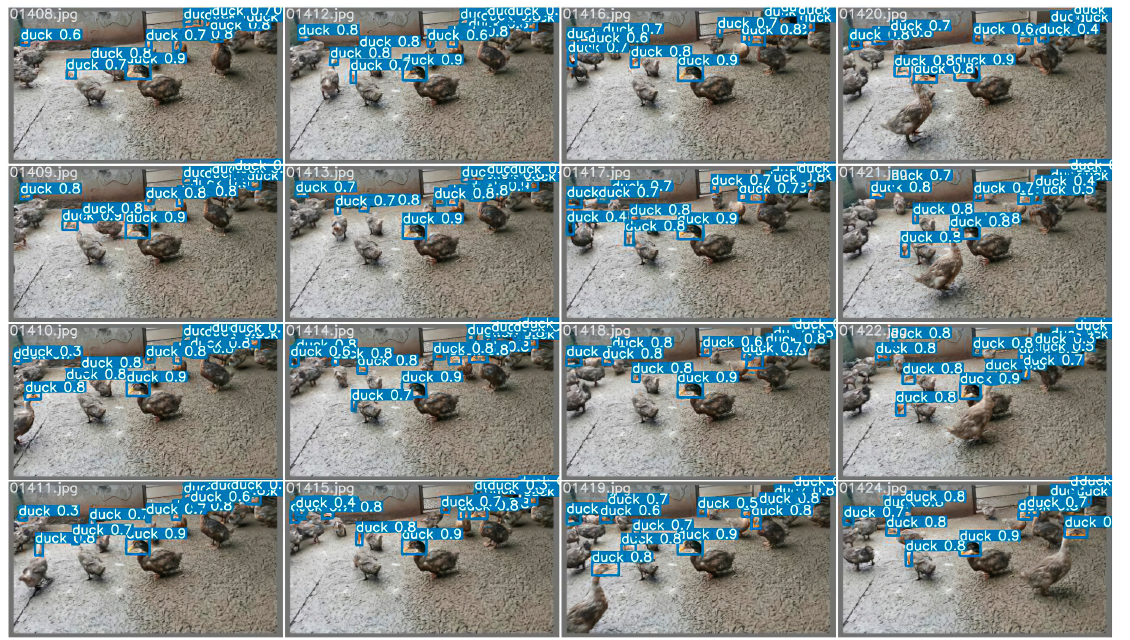
Figure 8. The effect of the hemp duck sex estimation model. The locations, masking conditions, and individual behaviors of the ducks vary in each extracted frame. In the final model, the accuracy reached 99.29%, F1 score reached 98.60%, and fps reached 269.68.